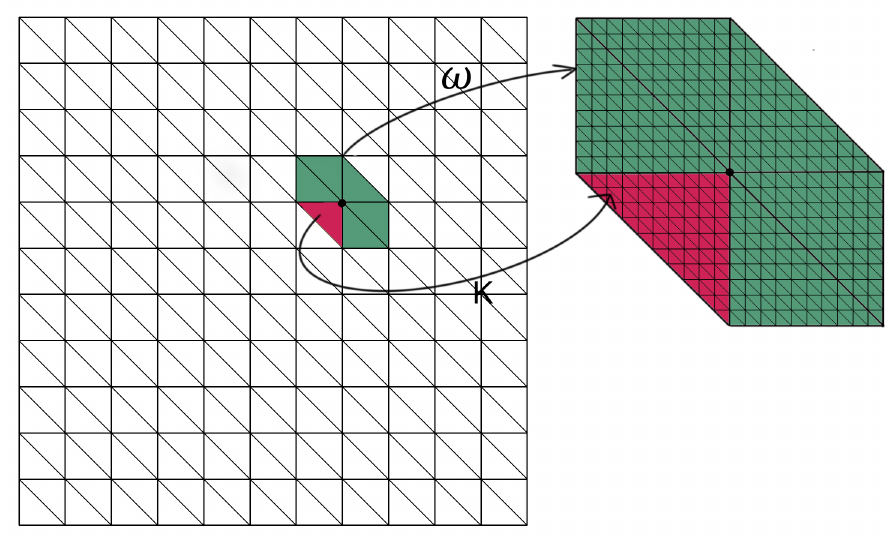
Figure 1. An illustration of coarse mesh ( left ), a coarse neighborhood and coarse blocks ( right